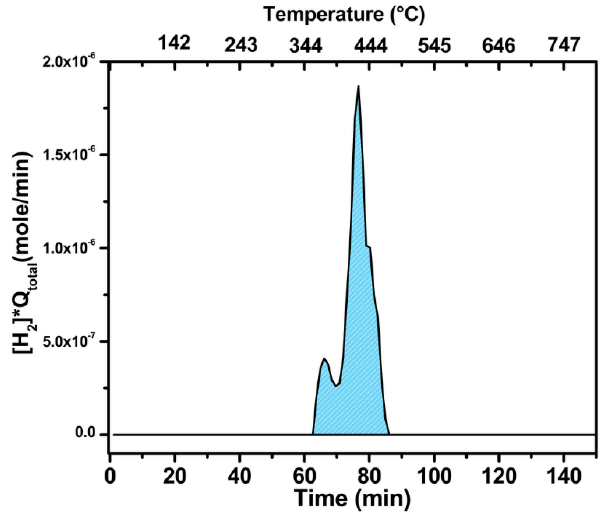
Figure 5. H 2 -TPD of the SrNiO 3 perovskite catalyst.